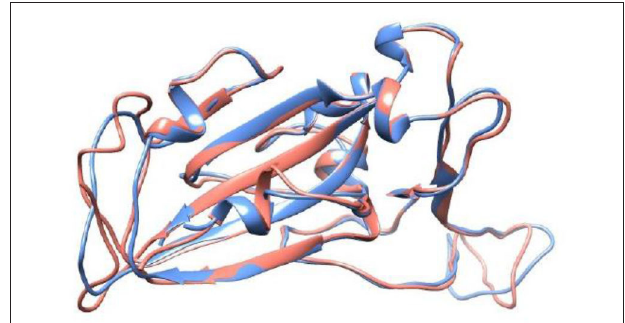
FIGURE 2 | Crystal structure of the SARS-CoV-1S RBD (PDB id 2AJF, chain E) and the modeled SARS-CoV-2S RBD (wildtype). See text for details regarding the modeling aspects. These macromolecules are shown, respectively, in blue and red in a ribbon representation. The root-mean-square deviation (RMSD) between these structures is equal to 0.64